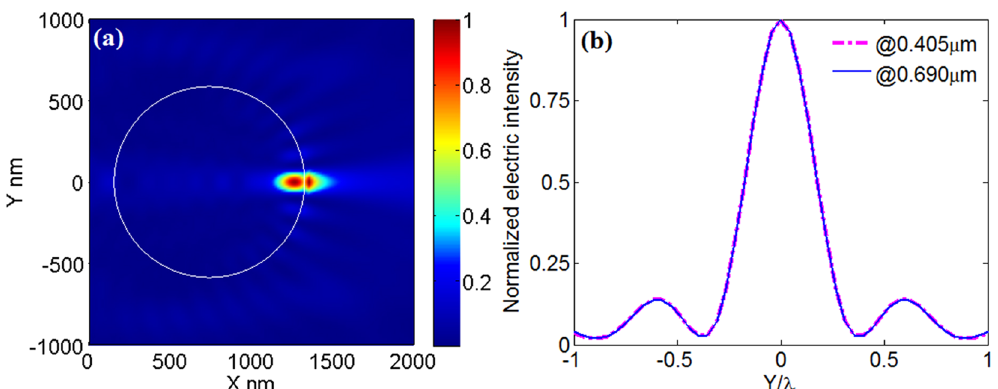
Figure 4. ( a ) Electric intensity distribution around the microsphere immerged in deionized water. The system parameters are: λ 0 = 0.405 μ m, r = 0.587 μ m, n 1 = 1.34, n 2 = 1.56. ( b ) The transverse curves at the maximum value of electric intensity in Fig. 3(a) (blue) and in Fig. 4(a)